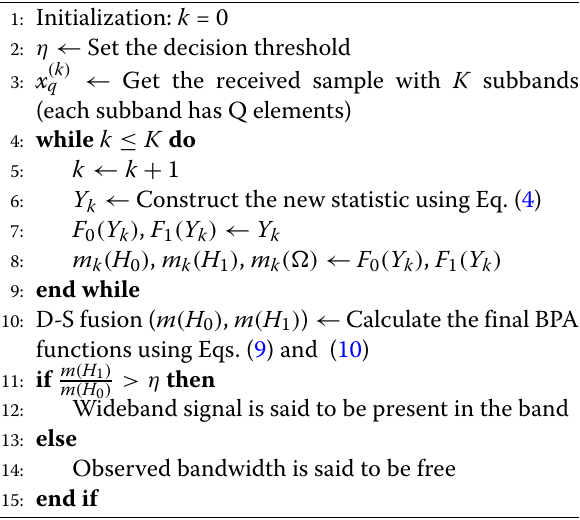
Algorithm 1 Proposed SS method with small sample size